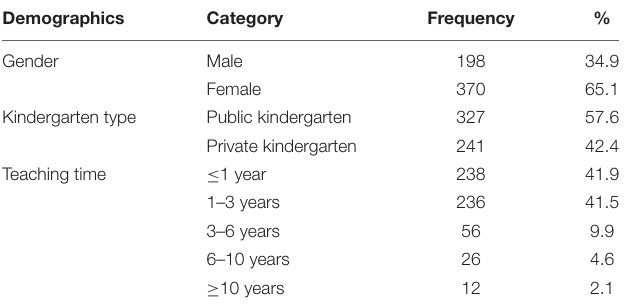
TABLE 1 | Demographics of the survey respondents ( N = 568).